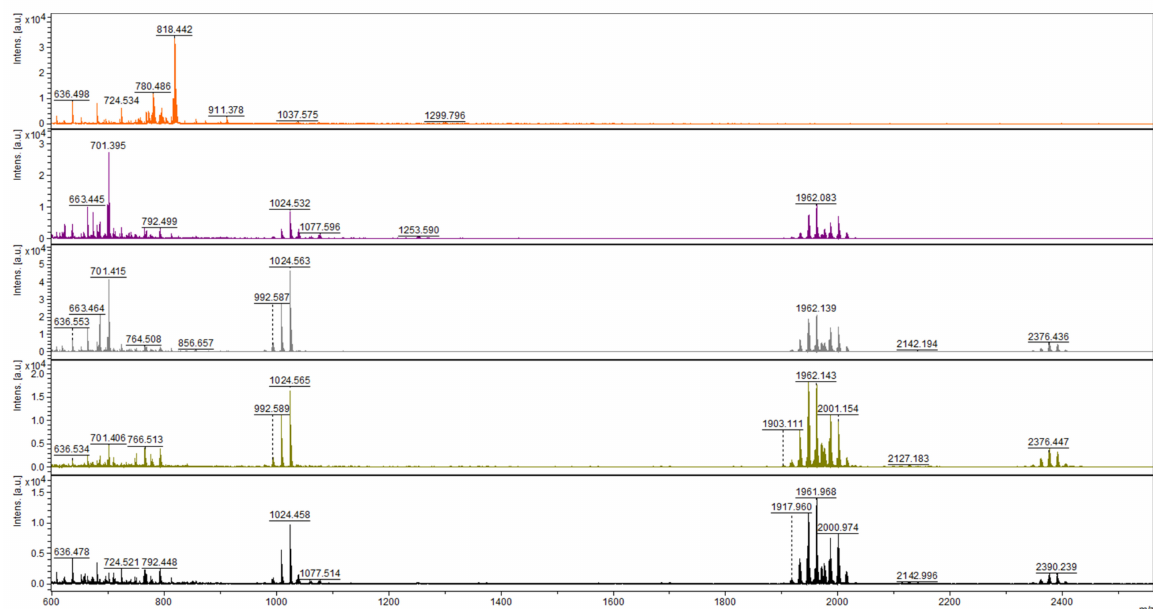
Figure 2. Mass spectra of short peptides isolated from the culture of T. atroviride O1 cultivated in light–dark conditions (organized in rows). Day of cultivation from the top—2nd, 3rd, 5th, 6th, and 12th. Atroviridins spectrum ( m / z between 1900 and 2000) was first detected on the 3rd day of cultivation (second